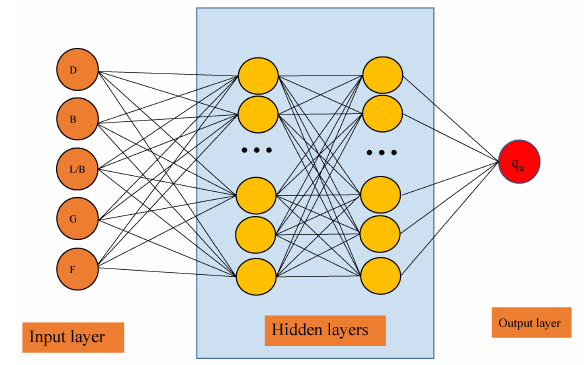
Fig. 1. Example of a DNN model of 5 inputs, 2 hidden layers and 1